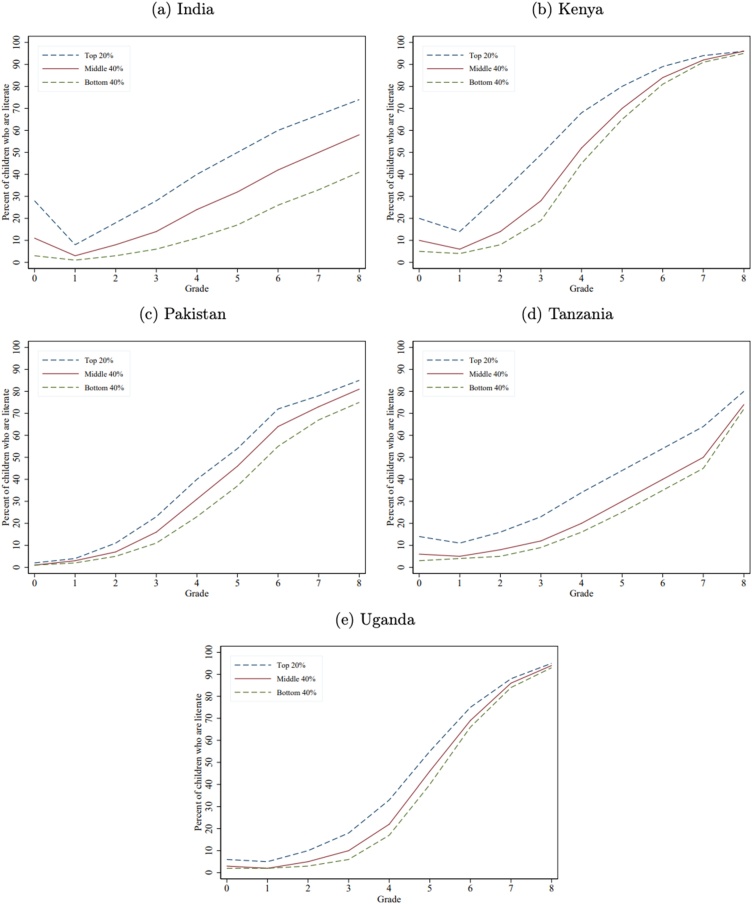
Learning Profiles by Wealth: English (All Ages).